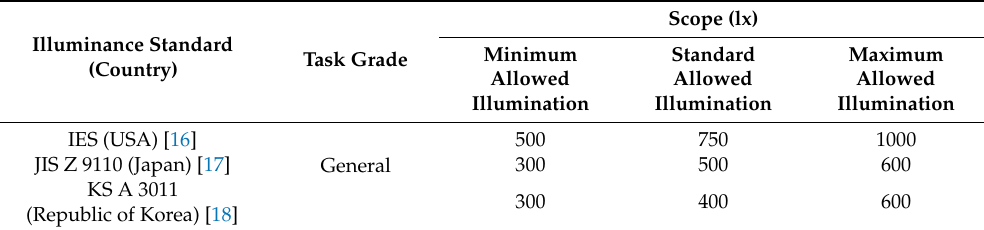
Table 2. Optimal indoor illuminance standards by country.